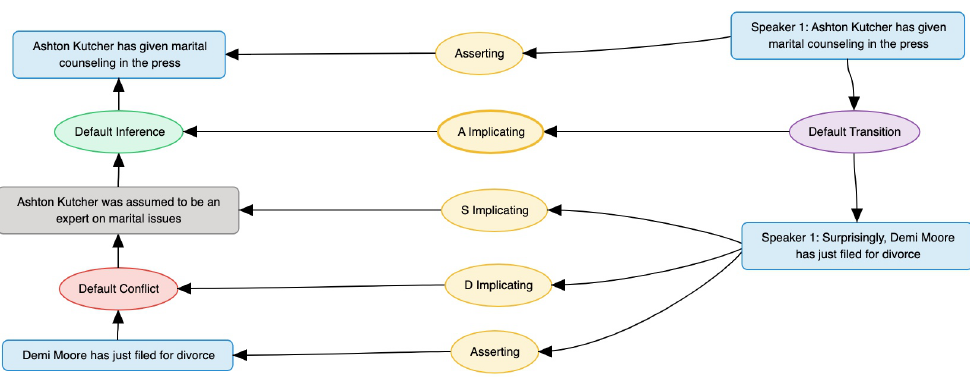
Figure 6. IAT CI diagram for the implicit inferential structure in Example